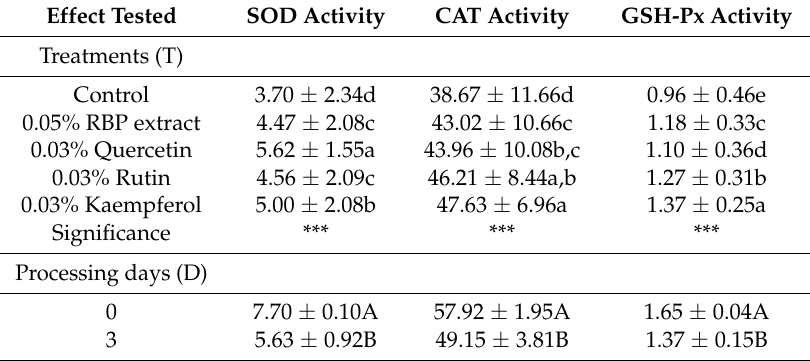
Table 2. Two-way ANOVA for different treatments, processing days, and their interaction on enzyme activity.